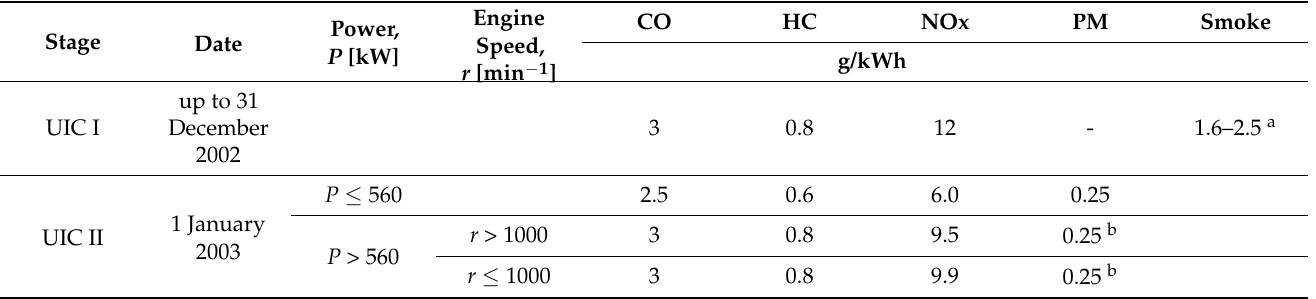
Table 1. UIC624 ICE Emission Standards